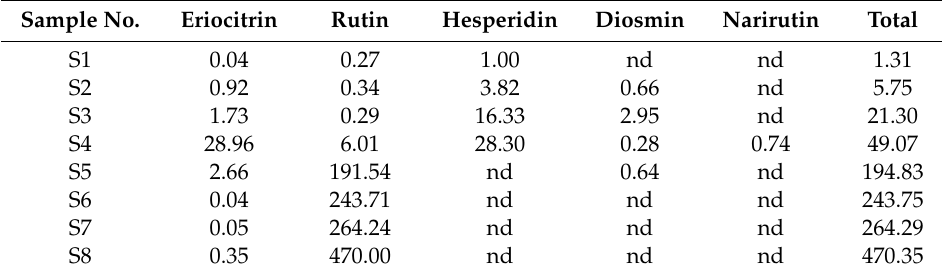
Table 2. The contents of five flavonoid glycosides in eight lemonade samples ( µ g / 100 mL). Sample